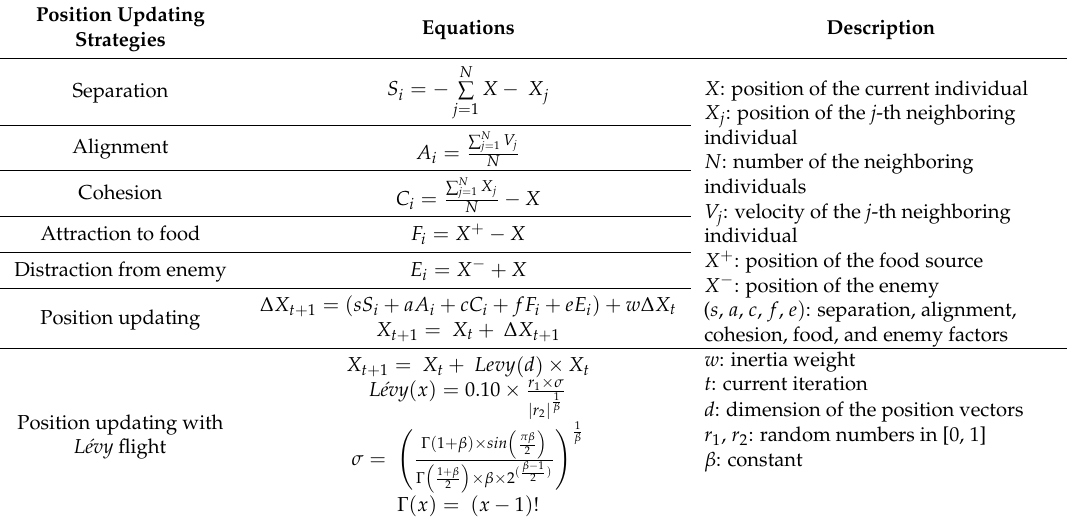
Table 1. Mathematical modeling of the five main position-changing strategies of dragonfly